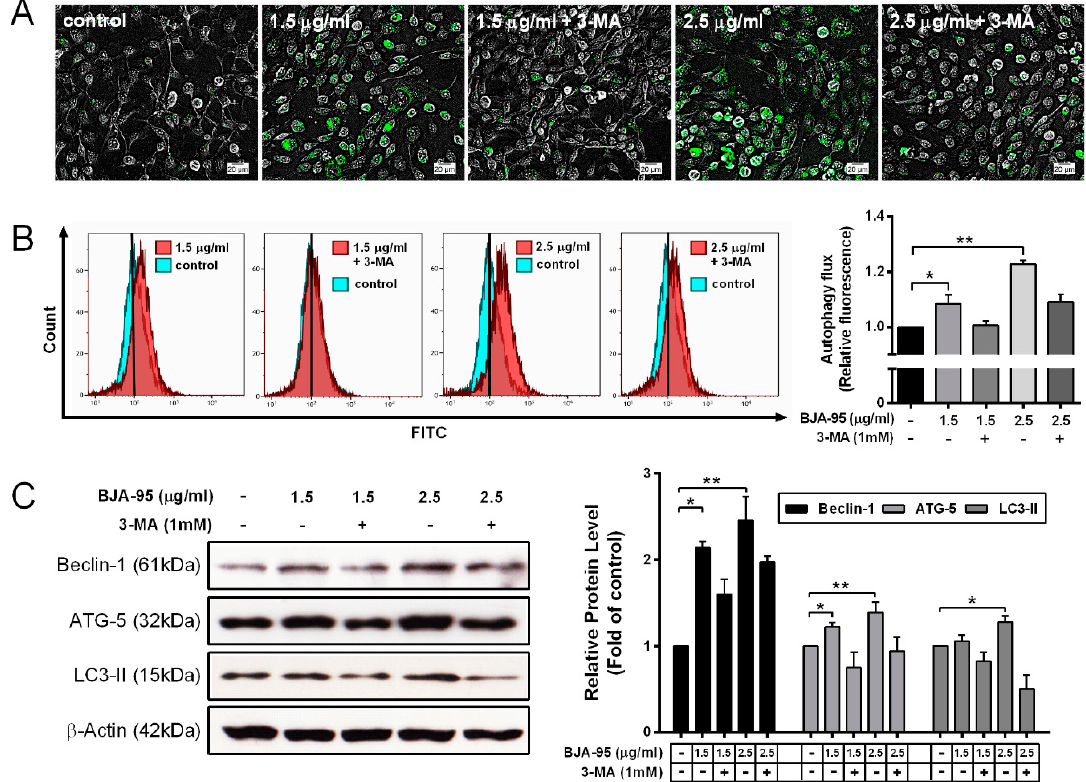
Figure 4. BJA-induced autophagy in CCA cells. The KKU-213 cells were treated with indicated concentrations of BJA-95. Specific fluorescence probes were then used to stain autophagic vacuoles. ( A ) Representative photos of autophagic vacuoles were examined under fluorescence microscopy. ( B ) Autophagic flux was quantitated by flow cytometry. ( C ) The expression levels of autophagy marker proteins in KKU-213 cells after stimulation with BJA-95 at different concentrations. The amount of proteins applied in each lane was normalized by β -actin. Results are shown as mean ± SD values from three repeated independent experiments. (*) p < 0.05 and (**) p < 0.01 when compared with the control.